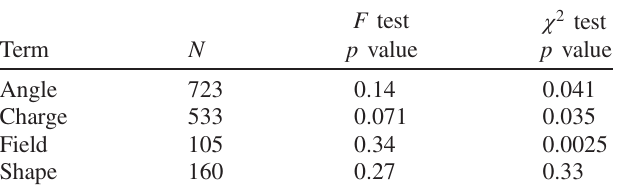
TABLE IV. Results for the ANOVA F test for response time and Likelihood Ratio χ 2 test for correctness for four features (Angle, Charge, Shape, and Field). The N value reflects the number of relevant problems for which each feature was